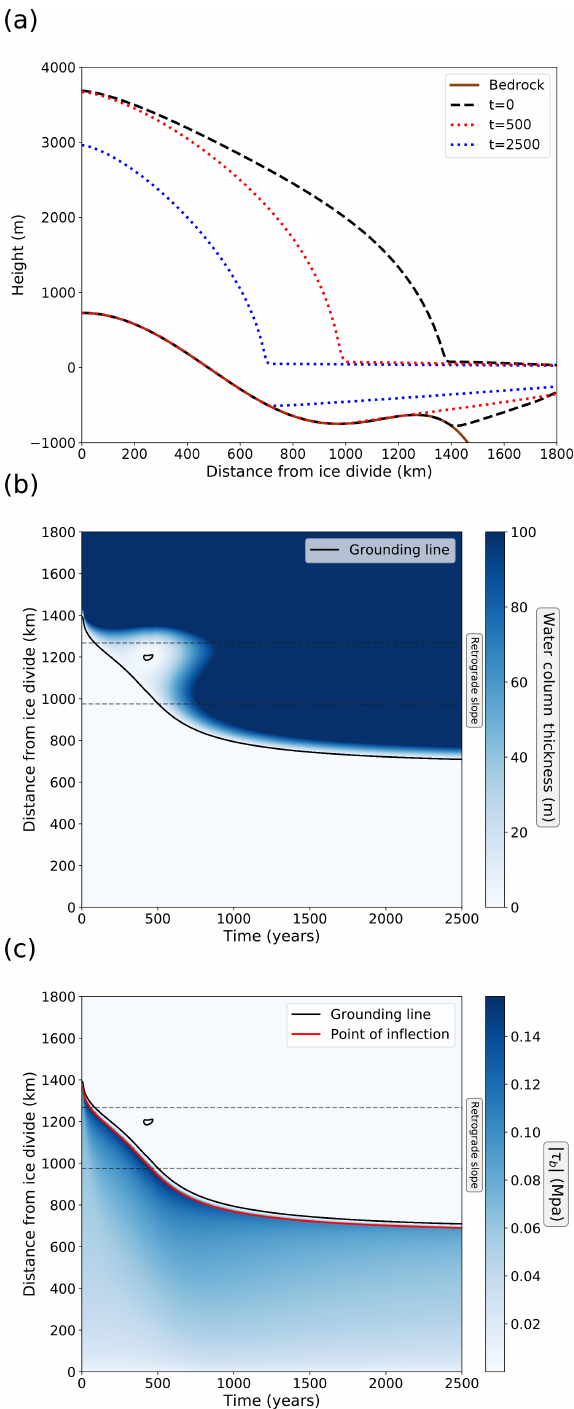
Figure 2. Retreat experiment details with the cavitation sliding rela- tion and W = 350km. (a) Ice sheet profiles during retreat. Bedrock profile is also shown. (b) Evolution of the water column thickness during retreat. (c) Evolution of the basal shear stress.